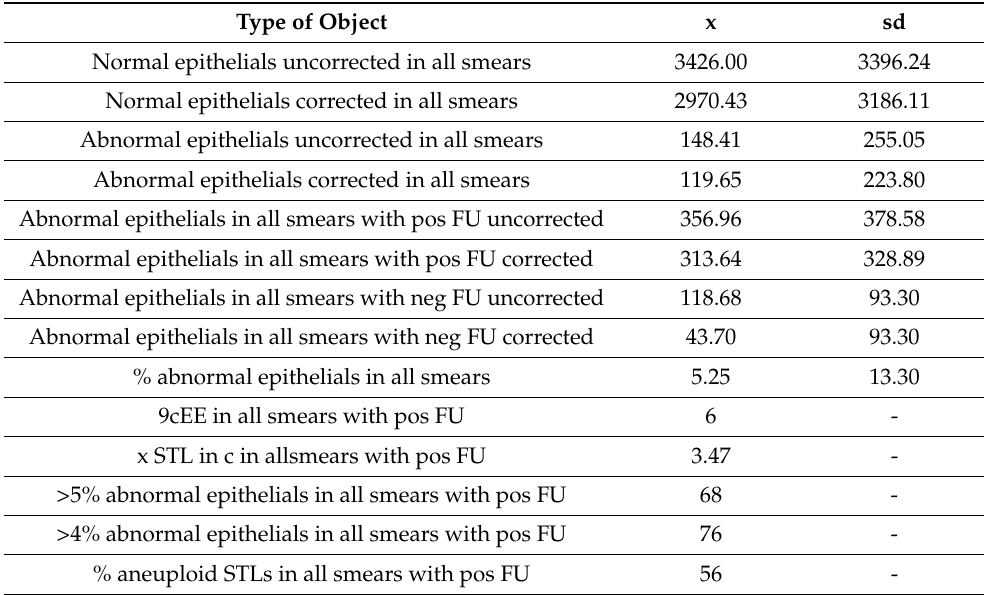
Table 2. Mean values (x) and standard deviations (sd) of classified nuclei in 92 EasyScan-AI-scanned oral smears from patients with Fanconi anemia, 25 with positive follow-up (SCC or high-grade OED). SCC: squamous cell carcinoma, OED: oral epithelial dysplasia; pos FU: positive follow-up; neg FU: negative follow-up; STL: stemline; c: content. Type of Object x sd Normal epithelials uncorrected in all smears Normal epithelials corrected in all smears Abnormal epithelials uncorrected in all